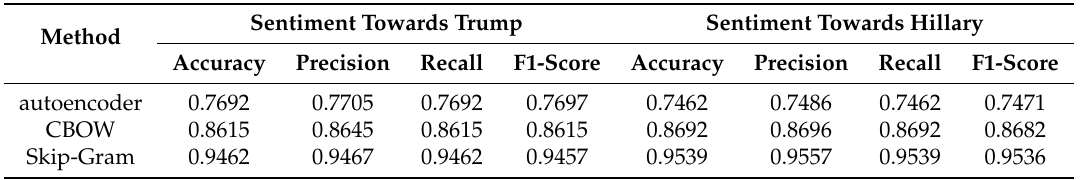
Table 2. Performance comparison between three word-modeling